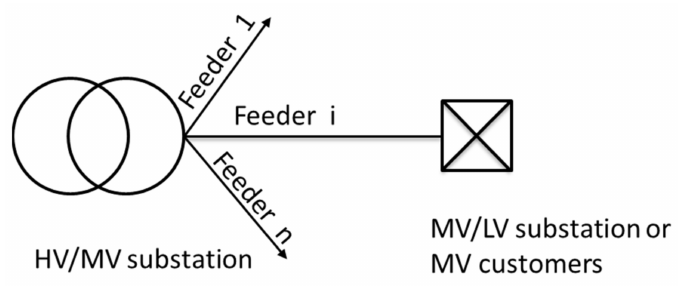
Figure 3. Customer connection